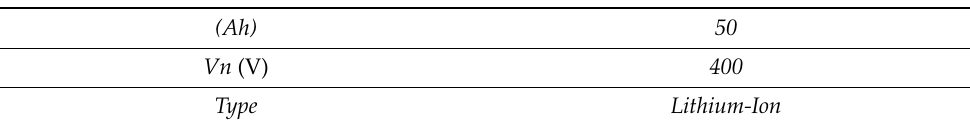
Table 8. Battery.